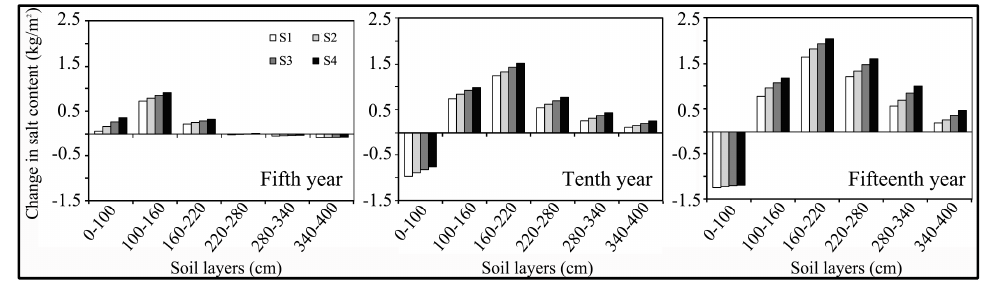
Figure 5. Change in salt content (kg/m 2 ) at maize harvest in a given layer compared to that during the initial years (increased salt content per square meter). S1–S4 are the simulated irrigation scenarios.